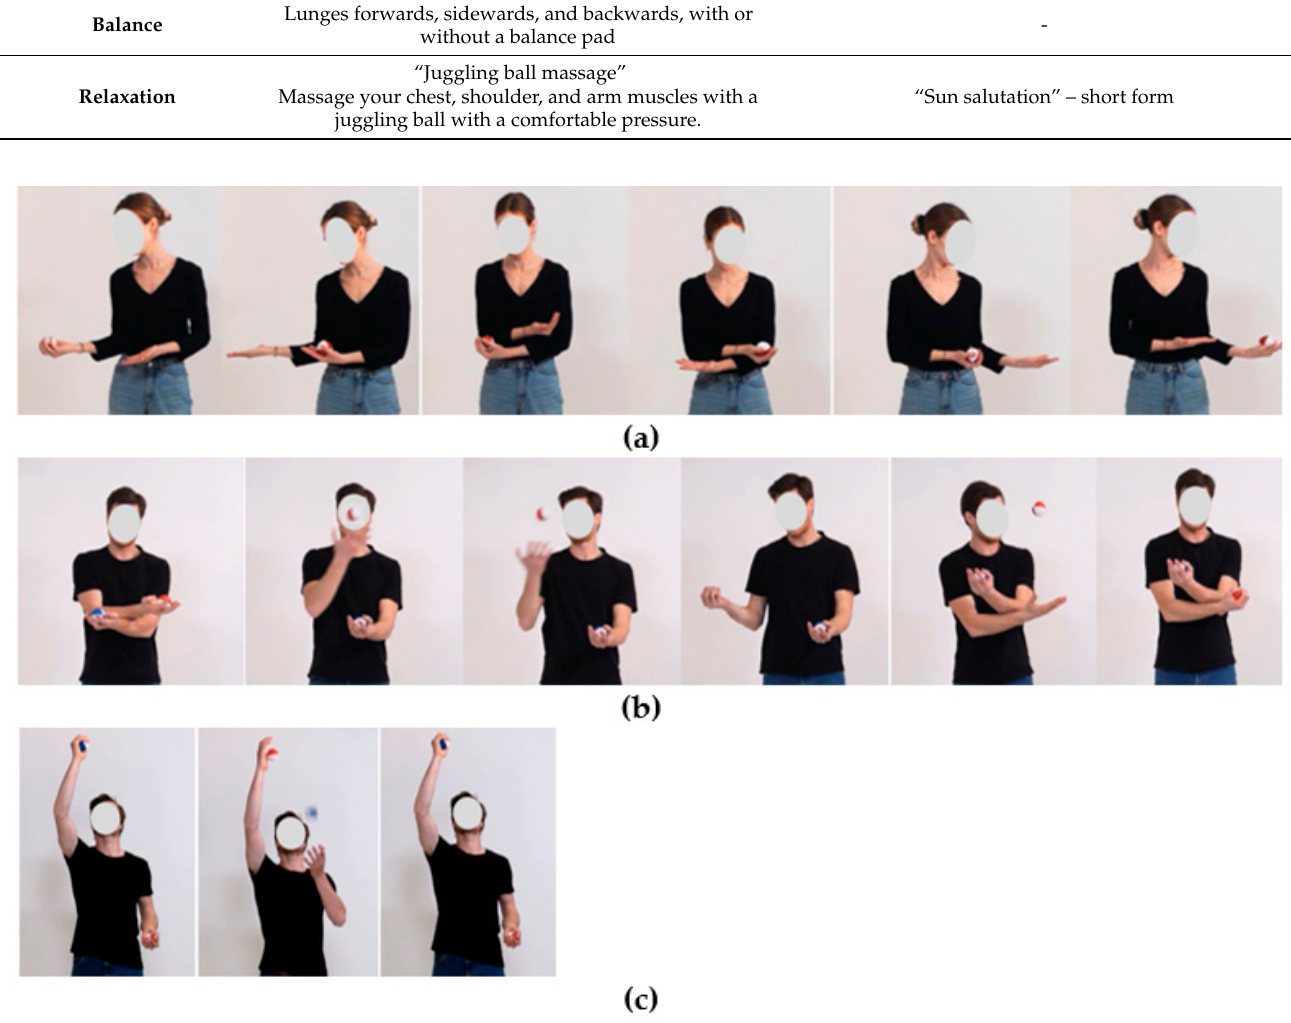
Figure 2. Exercises ( a ) “Line”, ( b ) “Wiper plus”, and ( c ) “Statue of Liberty”.